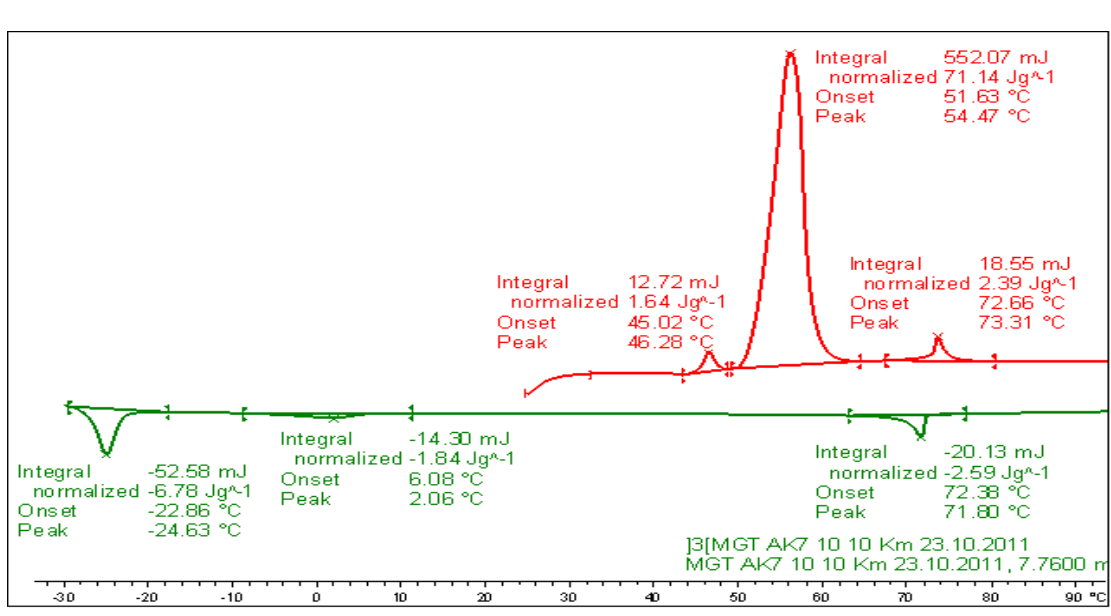
Figure 3. DSC studies (10 K/min) of Compound 1 ; values are taken from the first heating and cooling scans. Cr 54.5 (71.14) N 73.3 (2.39) Iso (°C); Iso 71.8 (−2.59) N 2.06